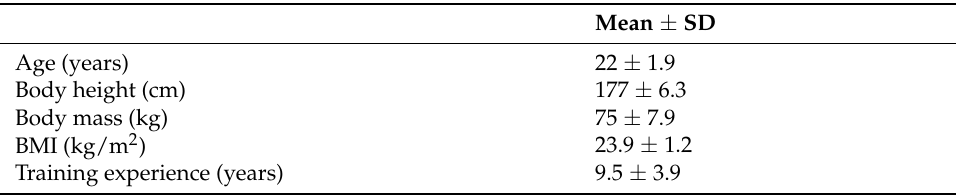
Table 1. Demographic and anthropometric data of the windsurfers ( n =